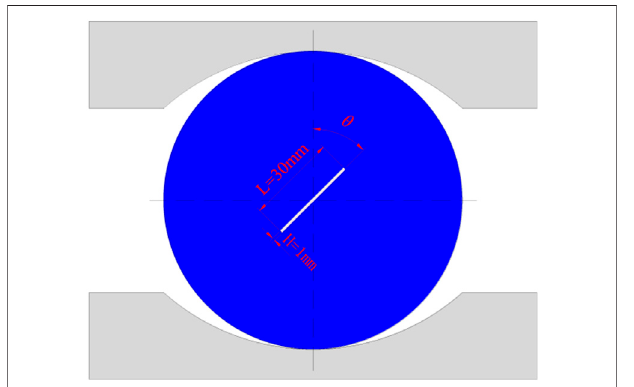
FIGURE 4 | 2D Brazilian test of the pre-cracked